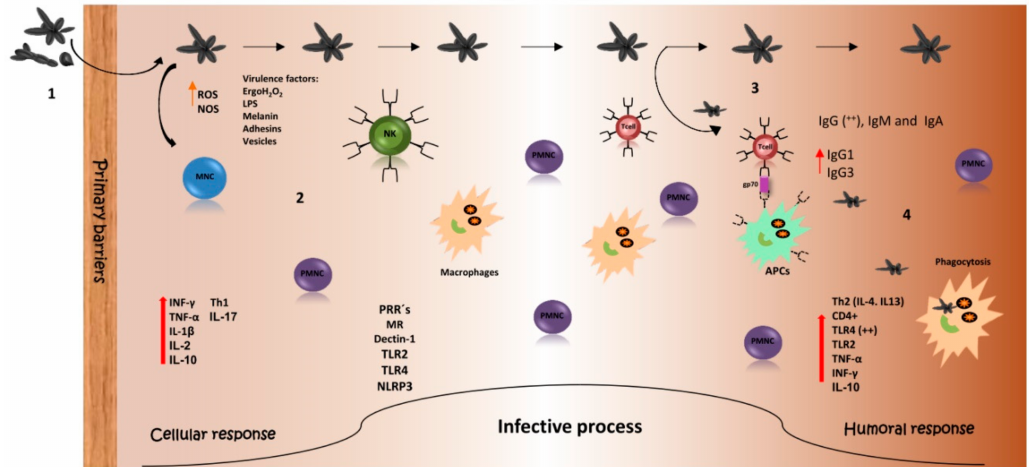
Figure 1. Host immune response against Sporothrix spp. ( 1 ) Infection with Sporothrix occurs by the traumatic inoculation of yeasts, conidia, or hyphae. Once the fungus crosses the primary barriers of the immune system, ( 2 ) components of the pathogen trigger the innate immune response including cells and molecules to attack the invader. ( 3 ) Several molecules of the fungus active T cells by being presented as antigens (i.e., peptides of Gp70). ( 4 ) Protective antibodies against the fungus are generated. All of this is for the clearance of the pathogen. MNC: Mononuclear cells. PMNC: Polymorphonuclear cells. NK: Natural Killer cells. Black arrows: infection sequence. Red arrows: increased production and participation during infection. Orange arrow: increased secretion during